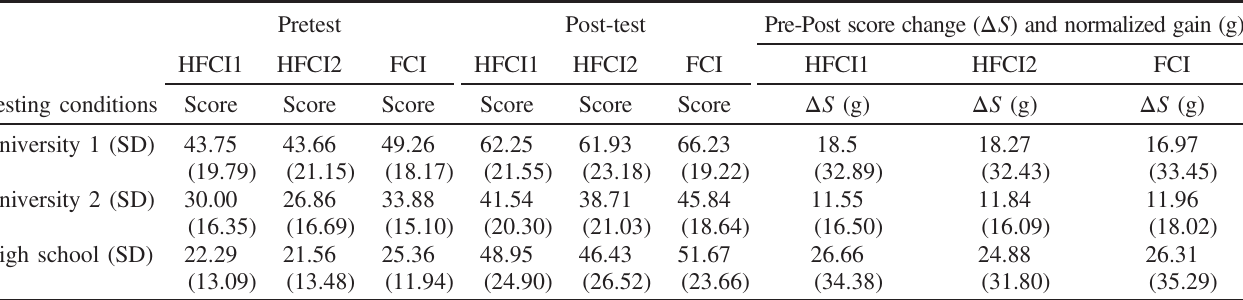
TABLE VI. Comparisons of test performances with data from three different institutions. University 1 is the institution for the original data set. The results for University 1 are copied from Table II for easy comparisons. University 2 ( N ¼ 501 ) is a public state university in a different state. The high school data ( N ¼ 657 ) are from a suburban high school located in a state different from both universities. The scores and normalized gains in the Table are in the scale of 0 –